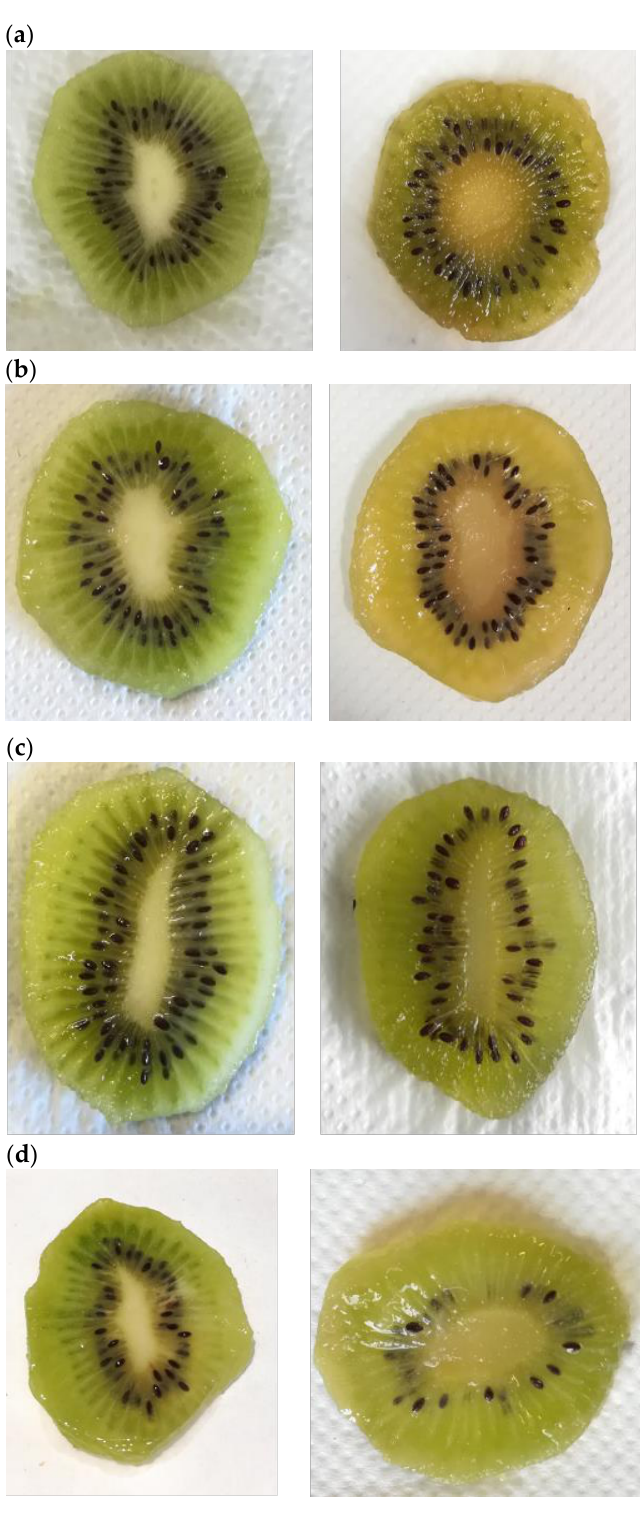
Figure 8. Visual appearance of fresh-cut kiwifruit at the beginning (on the left side) and at the end (on the right side) of the storage. ( a ) CTRL, control samples; ( b ) ALG, alginate samples; ( c ) ALG_HE_0.5, samples coated with alginate added with 0.5% of hop extract; and ( d ) ALG_HE_1, samples coated with alginate added with 1% of hop extract.